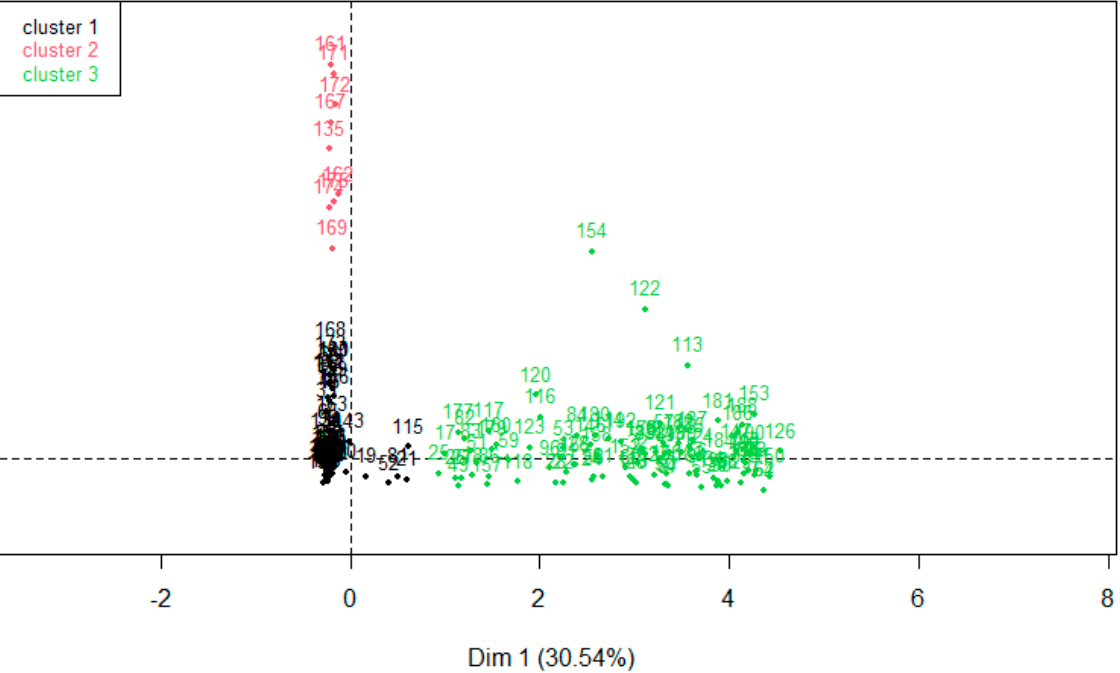
Figure 3. Hierarchical clustering on principal components (HCPC) on disclosed three variables (year, method and location) by factor map and cluster dendrogram. The figure shows the plot graph from a HCPC result: factor map in two dimensions: Dim1 (30.54%): Dimension 1 with 30.54% inertia; Dim2 13.03%: Dimension 2 with 13.03% inertia. Performs an agglomerative hierarchical clustering on results from a factor analysis (CA) with three clusters. Hierarchical clustering, used for identifying groups of similar observations in a data set. Cluster 1 (black): group of soil seed bank samples that correspond to M seed bank extraction method and year 2020. Cluster 2 (red): group of soil seed bank samples that correspond to M seed bank germination method and three years. Cluster 3 (green): group of soil seed bank samples that correspond to S seed bank (extraction and germination methods) and three years. Figure 4 reflects the HCPC tree classification with seed bank data and disclosed three clusters (Cluster Dendrogram). The cluster 1 (in green) was mainly formed by Picris echi- oides L. (PICEC), Poa annua L. (POAAN), Sonchus oleraceous (L.) L. (SONOL) and Stellaria media (L.) Vill. (STEME). Cluster 2 (red) included mostly Anacyclus clavatus (Desf.) Pers. (ANACL), and cluster 3 (black) comprised of several species, including Descurainia sophia (L.) Webb ex Prantl. (DESSO), Papaver rhoeas L. (PAPRH) and Portulaca oleracea L. (PO- ROL). In all cases, the clusters were characterized by variables whose values did not differ significantly from the mean.